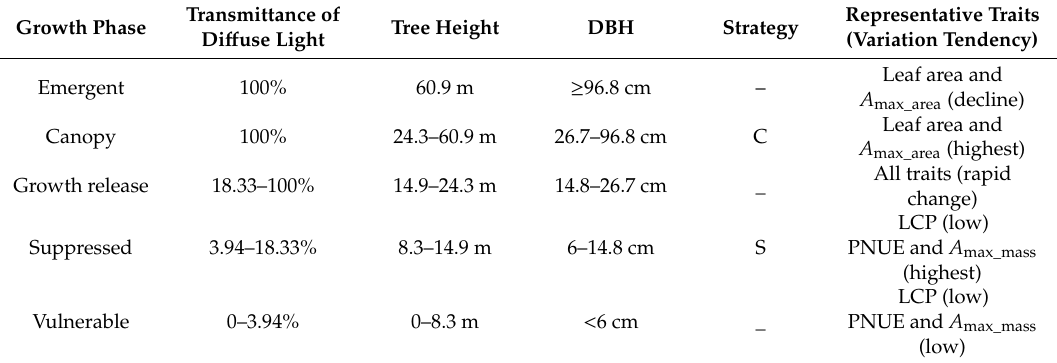
Table 1. Growth phases and changes in the adaptive strategy of leaf traits of P. chinensis. The letters in the strategy column indicate the following: C-relatively “competitive” strategy; S-relatively “stress-tolerant”